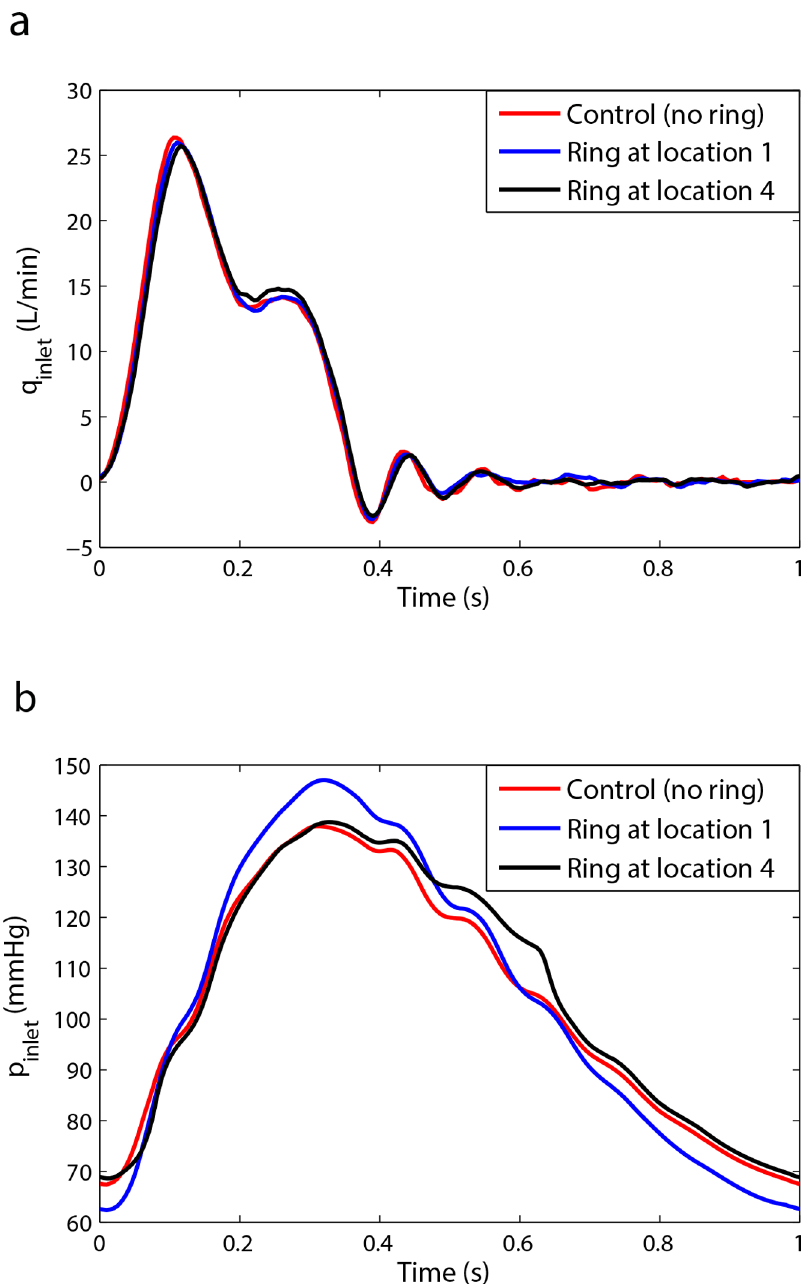
Figure 9. Samples of hemodynamic waveforms for ring experiment. a) Samples of aortic input flow waves at HR=60 bpm and CO=5 L/min for setup 3 (ring experiment). b) Samples of aortic input pressure waves at HR=60 bpm and CO=5 L/min for setup 3 (ring experiment). Since our LV simulator acts more as a flow source, the alterations from control case are insignificant in flow waves. However, the alterations from the control case in pressure waves are rather